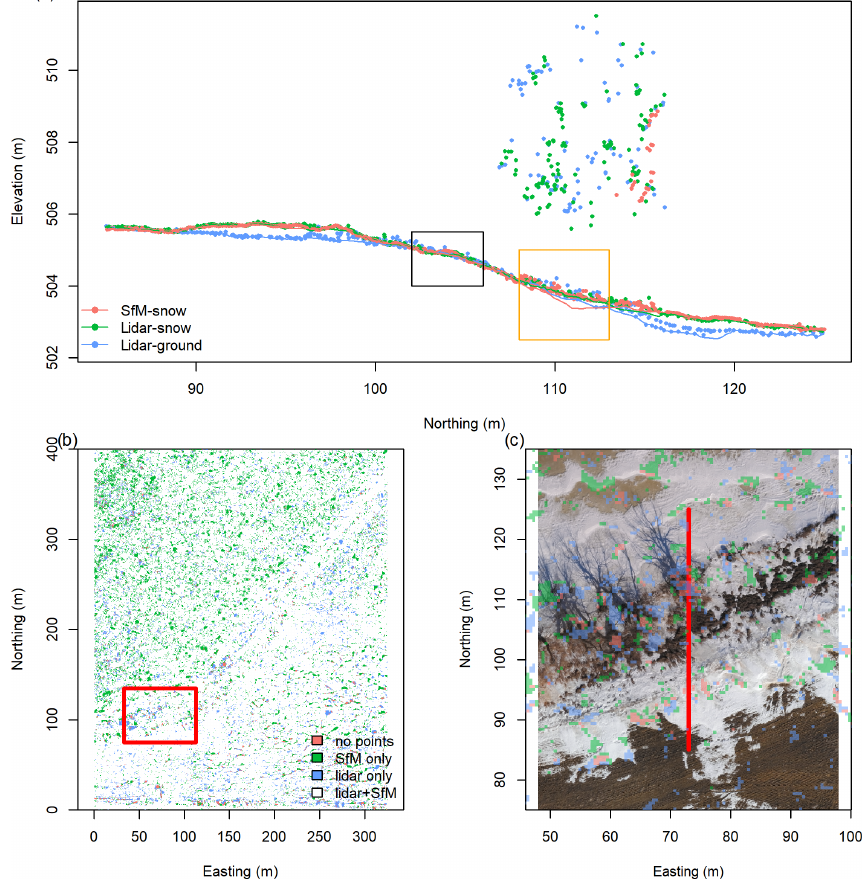
Figure 9. Clavet (20 March 2019) study site with an example (a) cross section with all points and the interpolated vegetation-free surface (lines) for SfM-snow (red), lidar-snow (green), and lidar-ground (blue) surveys. The study area is classified by areas with greater than 1pt per 0.25m − 2 in (b) with respect to point clouds obtained from UAV-lidar and UAV-SfM techniques. In (a) the black polygon highlights areas of dense shrubs while the orange polygon highlights interpolation artefacts of the UAV SfM. The red inset polygon in (b) identifies the area of the orthomosaics displayed in (c) with the same overlain transparent point type classification colour scheme as shown in (b) . The red line in (c) corresponds to the cross section plotted in (a)